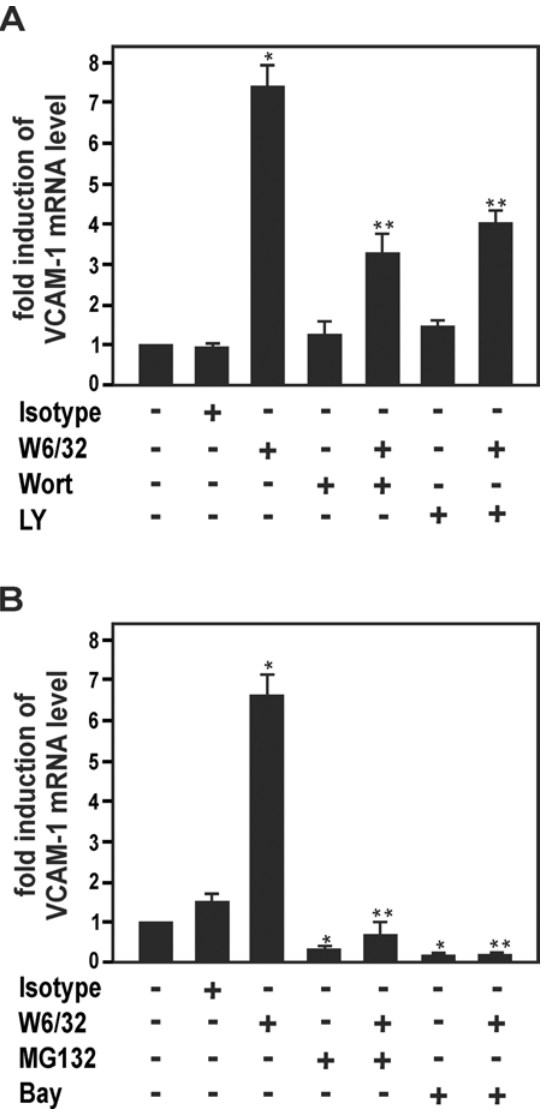
Fig 2. Signaling cascades of HLA I Ab-dependent VCAM-1 up-regulation in HUVECs. (A, B) HUVECs were incubated with HLA I Ab W6/32 or isotype control (10 μ g/ml) for 18 h after pre-treatment for 30 min with, (A) the PI3K/Akt pathway inhibitors wortmannin (1 μ M) and LY294002 (4 μ M), or with, (B) the NF- κ B pathway inhibitors MG132 (100 nM) and Bay 11 – 7085 (10 μ M). Cells were lysed and subjected to RT-PCR analysis. The fold induction of mRNA levels is indicated. Data are mean ± SEM from three independent experiments. * p (cid:3) 0.05, significant differences treatment versus control; ** p (cid:3) 0.05, W6/32 versus W6/32 plus inhibitor. Wort, wortmannin; LY, LY294002; Bay, Bay 11 – 7085.